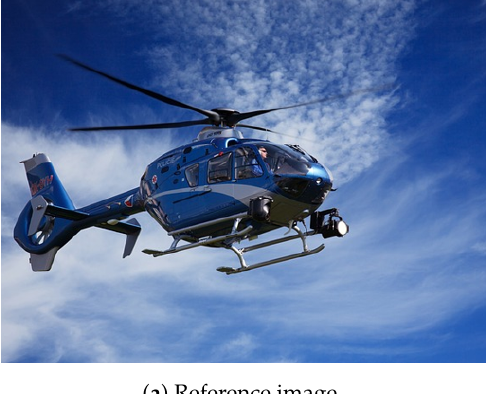
( a ) Reference image. ( b ) Distorted image.